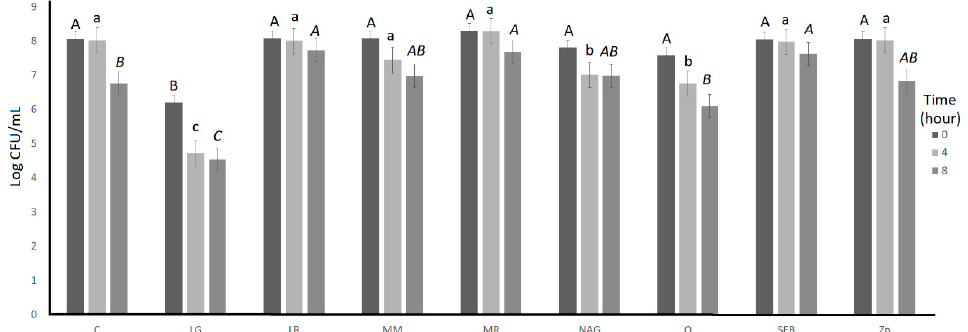
Figure 3. Log counts of Streptococcus thermophilus showing its bile tolerance as in fl uenced by treatments over 8 h. C = control, LG = L-glutamine (7 g/L), Q = quercetin (700 mg/L), SEB = slippery elm bark (210 mg/L), MR = marshmallow root (1340 mg/L), NAG = N-acetyl-D-glucosamine (210 mg/L), LR = licorice root (210 mg/L), MM = maitake mushrooms (42 mg/L), and ZN = zinc orotate (70 mg/L). Average of three replicates. A,B Values with di ff erent le tt ers at 0 h are signi fi cantly di ff erent ( p < 0.05). a,b,c Values with di ff erent le tt ers at 4 h are signi fi cantly di ff erent ( p < 0.05). A , B , C Values with di ff erent le tt ers at 8 h are signi fi cantly di ff erent ( p < 0.05). Error bars represent SE.